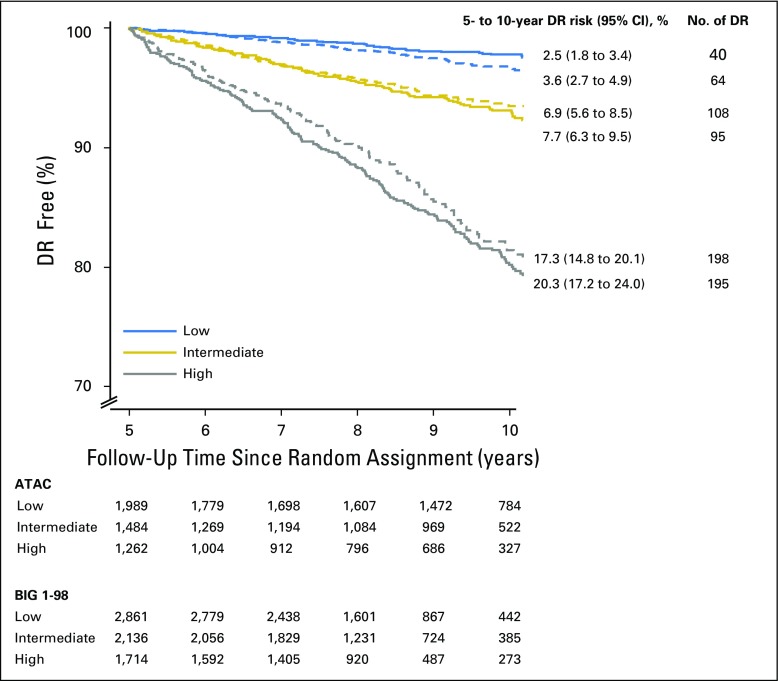
Kaplan-Meier curves and 5- to 10-year distant recurrence (DR) rates since random assignment for the overall population according to trial (solid lines, ATAC [Arimidex, Tamoxifen, Alone or Combination]; dashed lines, BIG [Breast International Group] 1-98).